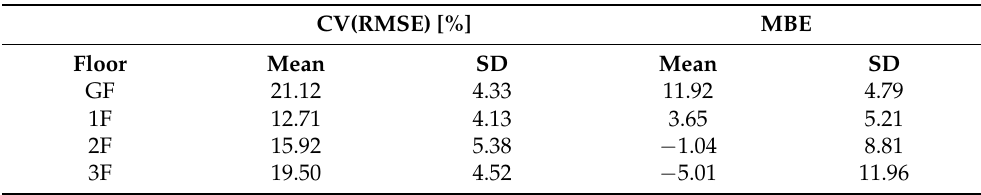
Table 3. Monthly calculation (Mean) and Standard Deviation (SD) of CV(RMSE) and MBE errors for heat demand prediction for each floor.